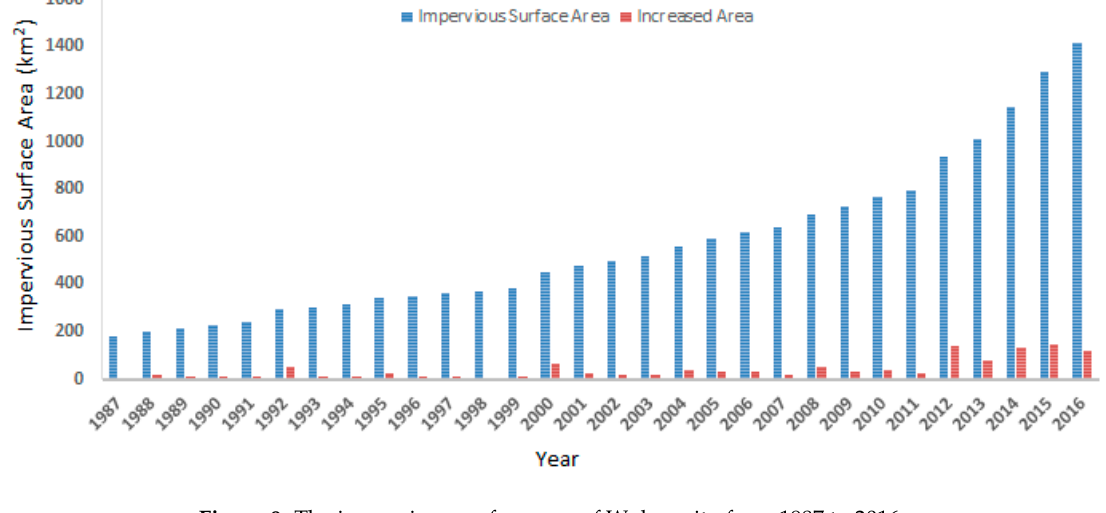
Figure 9. The impervious surface area of Wuhan city from 1987 to 2016.